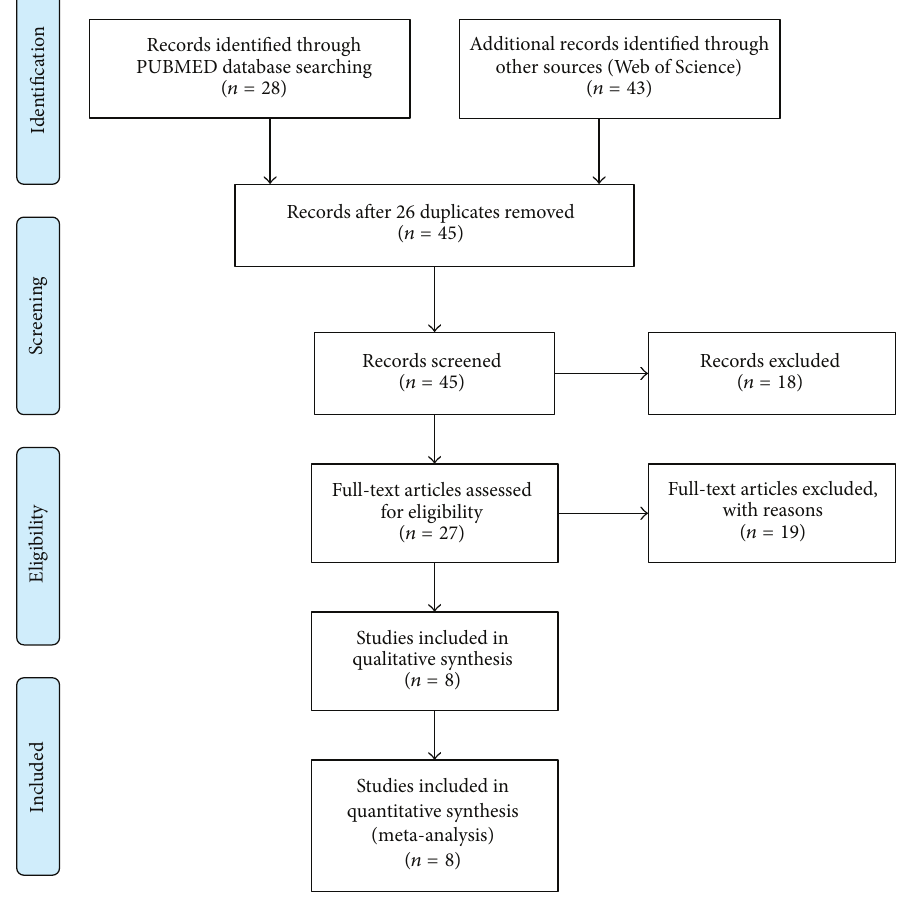
Figure 1: PRISMA flow